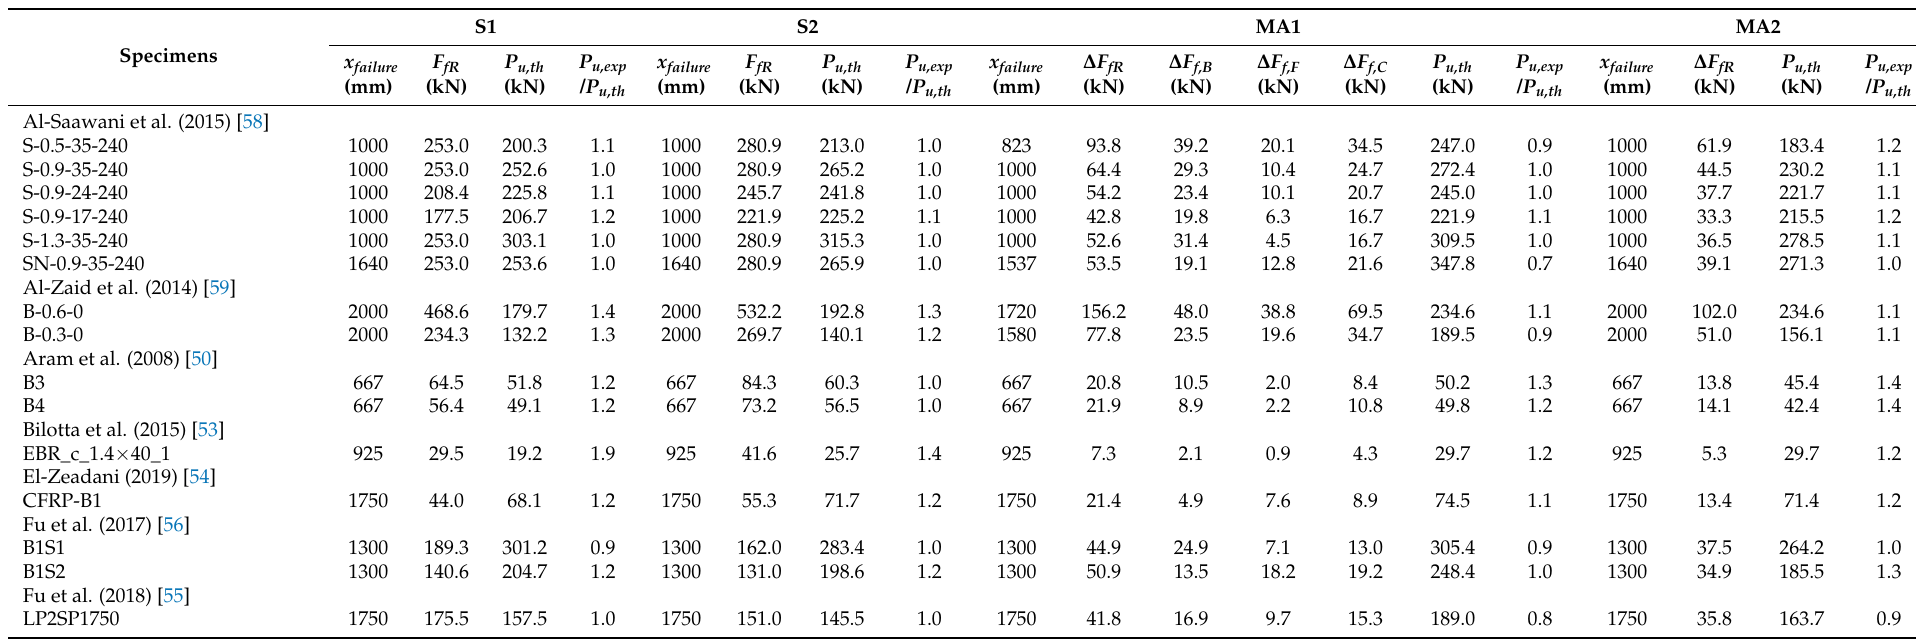
Table 7. Predicted values for ICD failure parameters in the studied beams according to the different